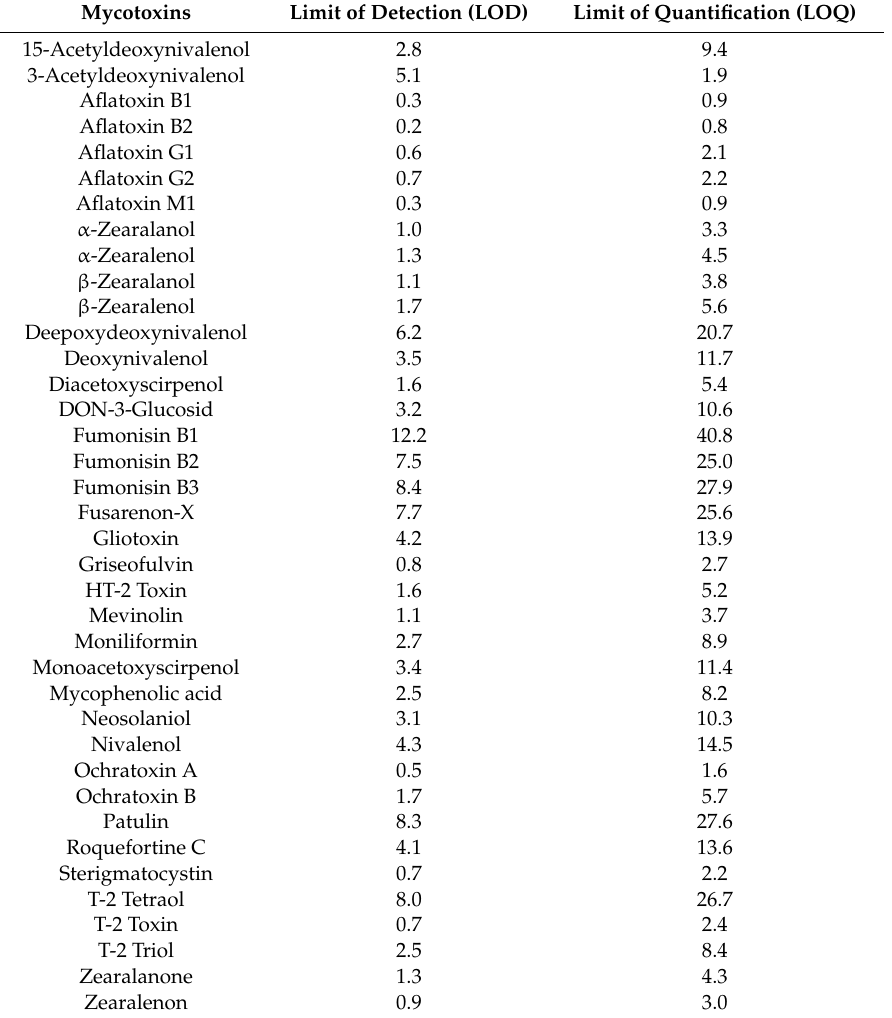
Table 3. Detection and quantification values for each mycotoxin (ng /